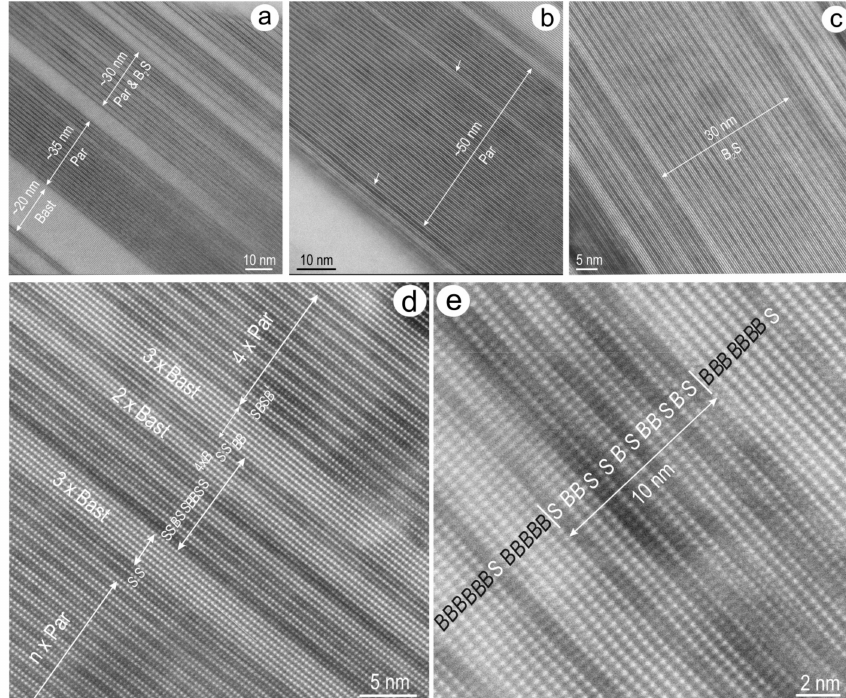
Figure 9. HAADF STEM images showing ordered and disordered stacking sequences over longer ( a – c ) and shorter ( d , e ) intervals; ( a ) Alternating periods of ~20–35 nm of different phases as marked accounting for transitional contrast changes or compositional variation; ( b , c ) Longer (50–30 nm) periods of parisite and B 2 S phase, respectively, interspersed with B stacks of variable widths; ( d , e ) Details of stacking sequences in parisite ( d ) and bastnäsite intervals ( e ) showing stacking disorder as marked. Note the presence of 1- or 2-periods of BSS slab stacks (corresponding to röntgenite) but with isolated occurrence or erratic distribution throughout the host stacking